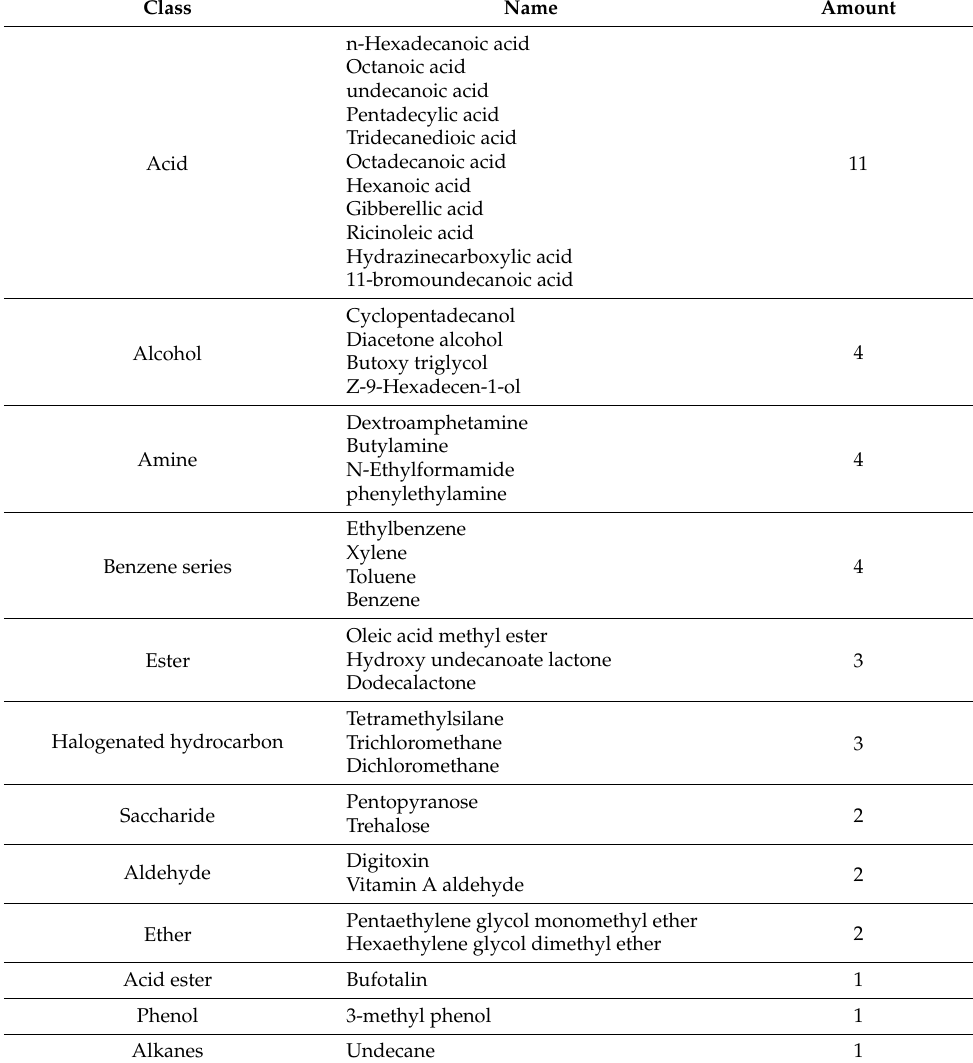
Figure 2. Mass spectrum of n-Hexadecanoic aide. Table 1. Major detected substances.